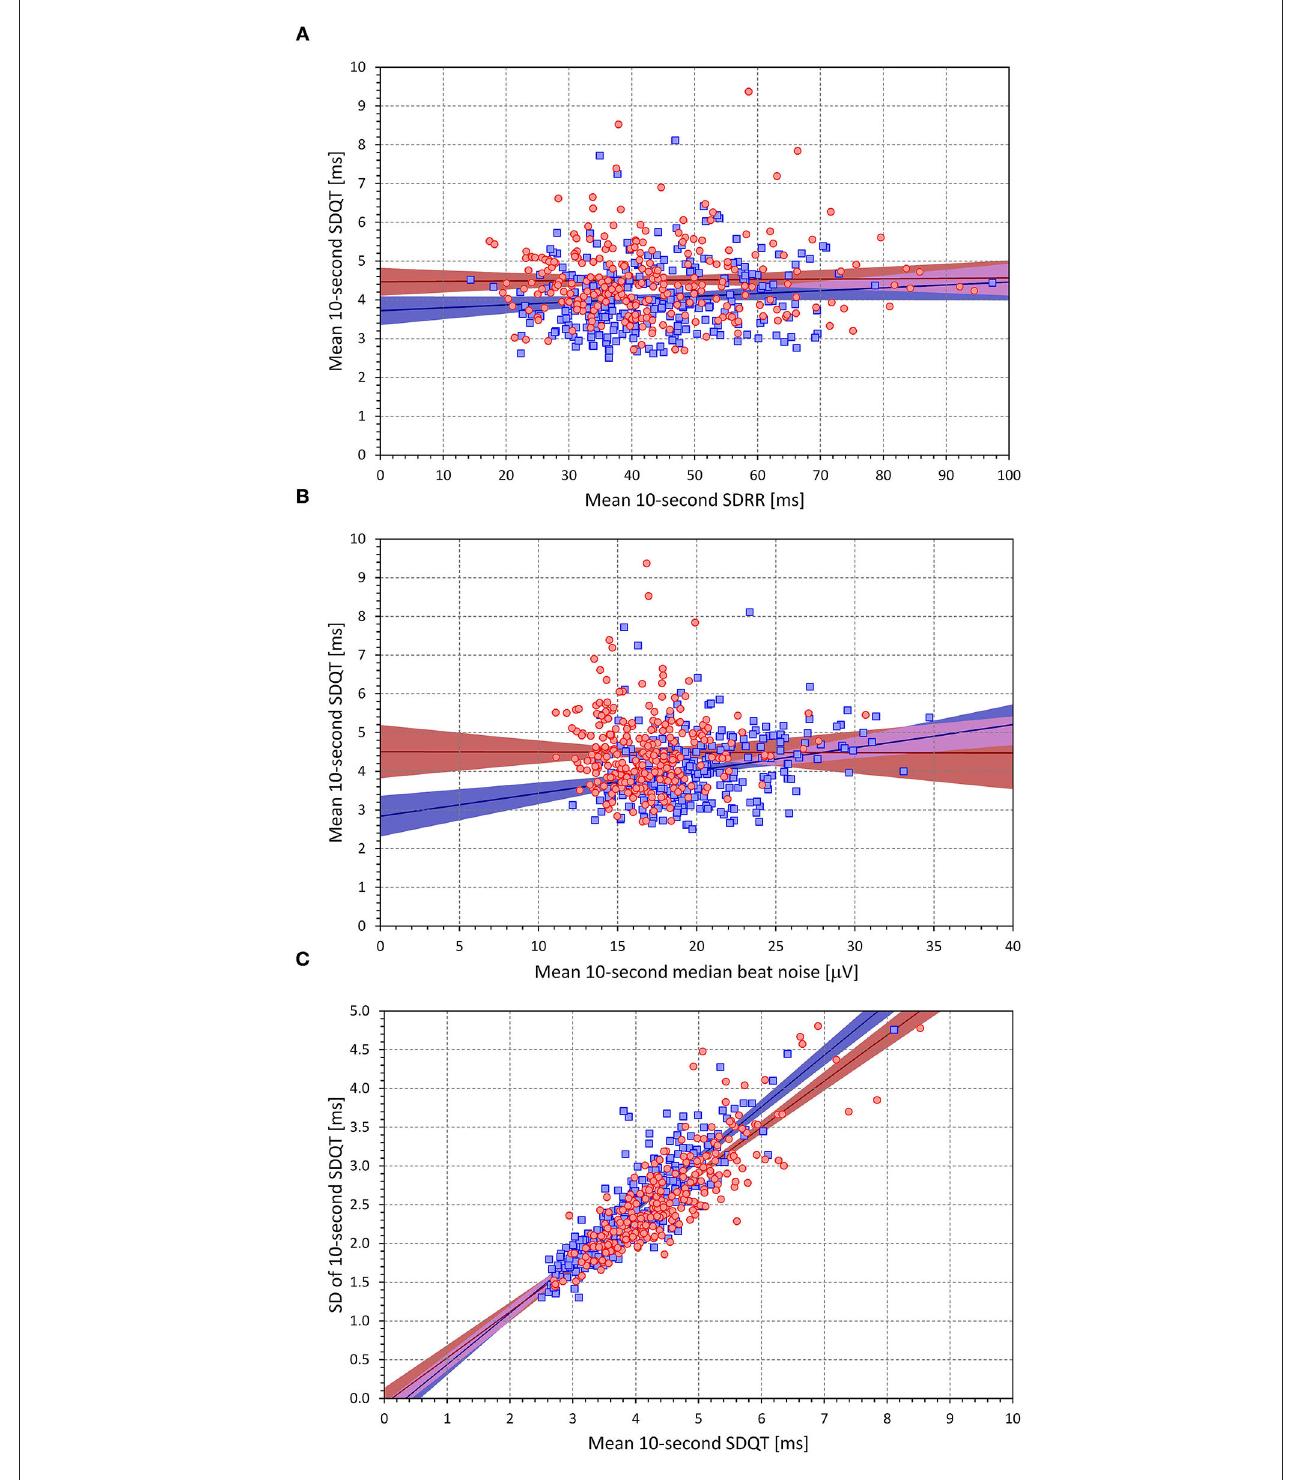
FIGURE 10 | Scatter diagrams showing population relationship between intra-subject means of 10-s SDRR and 10-s SDQT [top (A) ], intra-subject means of 10-s median beat noise, and 10-s SDQT [middle (B) ], and intra-subject means of 10-s SDQT and intra-subject standard deviations of 10-s SDQT [bottom (C) ]. In each panel, the red circle and blue square marks correspond to females and males, respectively. The red and blue lines show the linear regression models between the displayed characteristics, the light colored red and blue bands show the 95% confidence intervals of the linear regressions, the light-colored violet areas show the overlaps between the regression confidence intervals of both